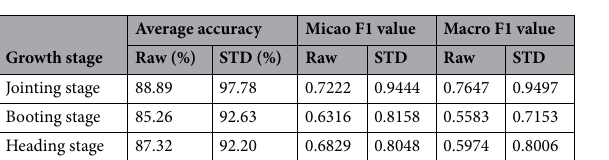
Table 1. Measures for SVM models at different